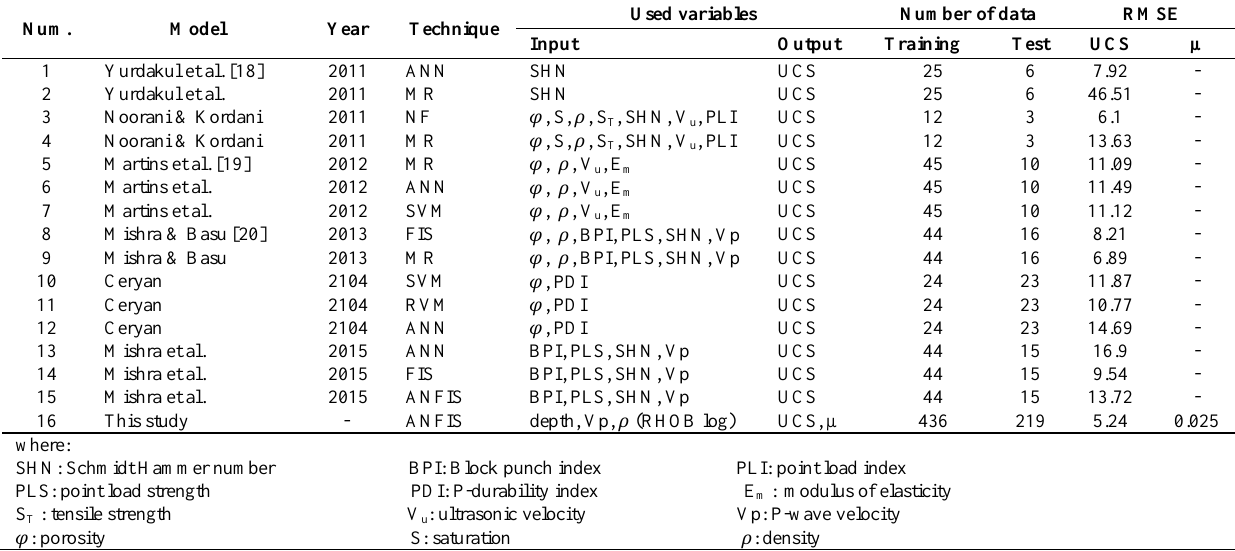
Table 3. A comparison between proposed model and recent intelligence and predictive